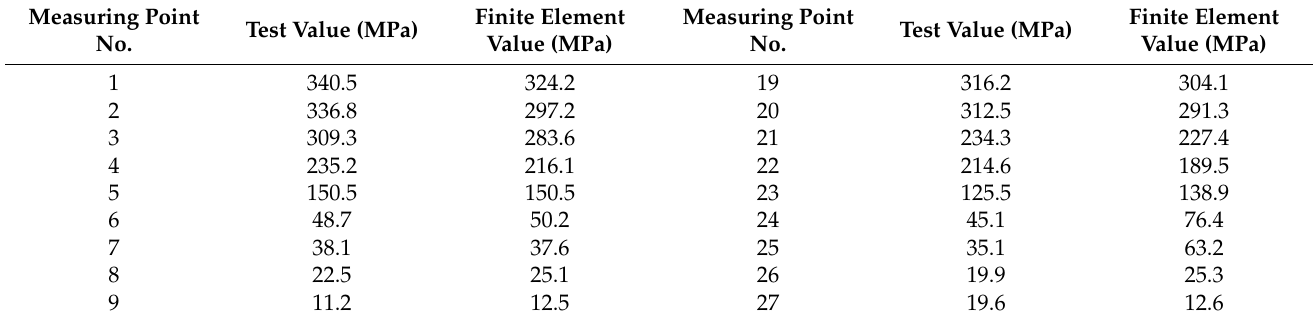
Table 2. Test value and finite element value in the weld of